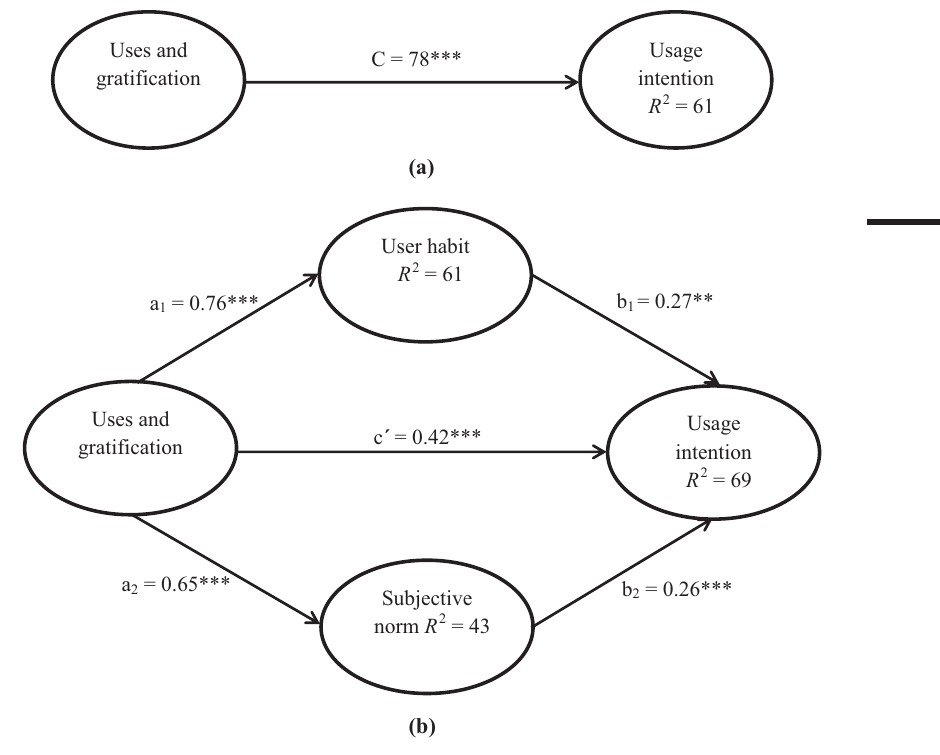
Figure 1. Structural model: multiple mediation